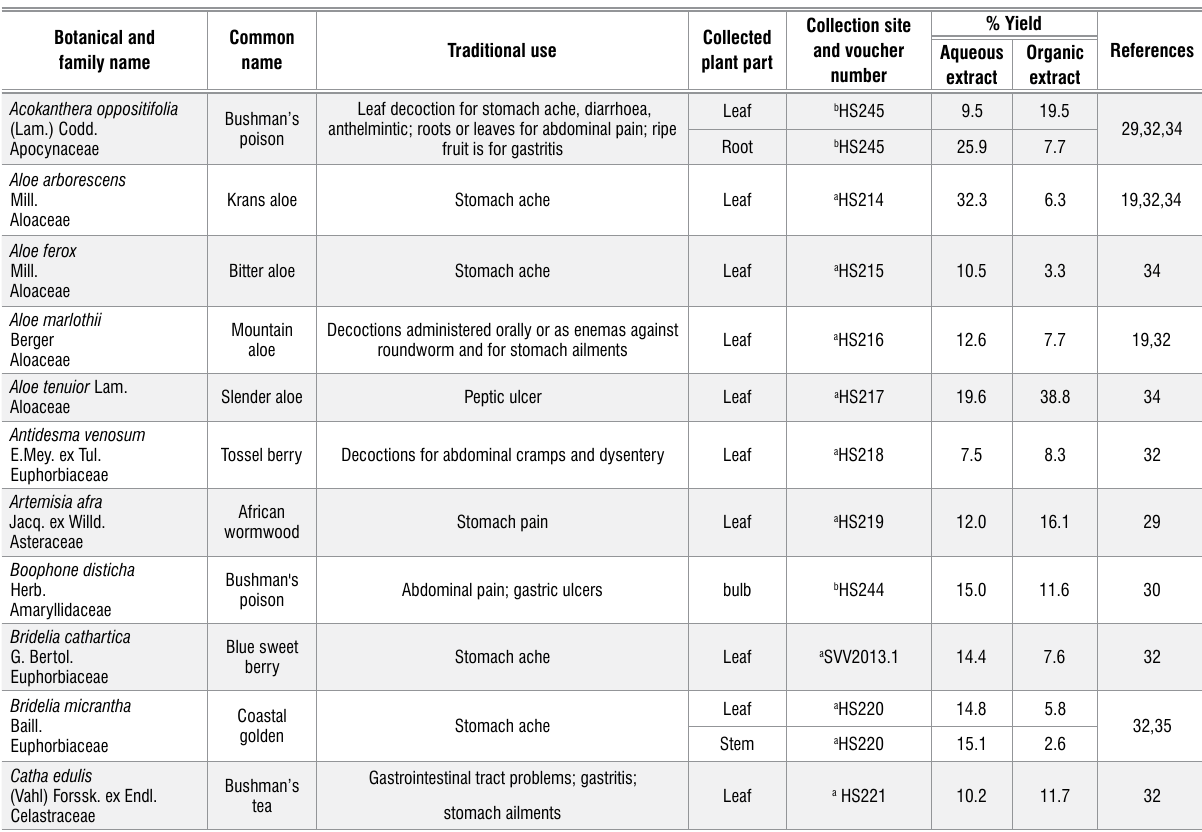
Southern African medicinal plants used traditionally to treat stomach